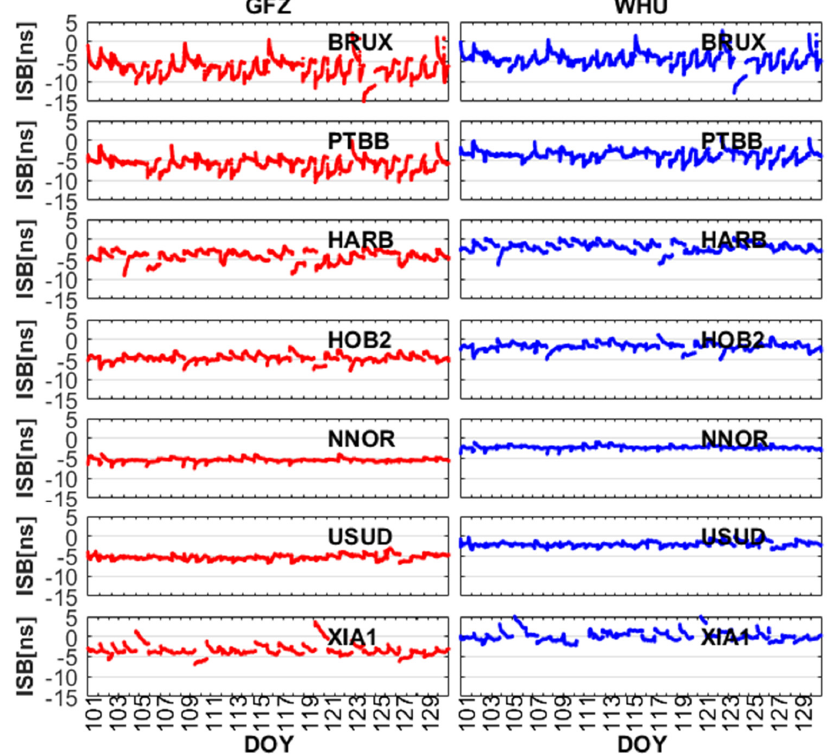
Figure 5. The inter-system bias (ISB) between BDS-2 (B1I/B3I) and BDS-3 (B1I/B3I) for Helmholtz